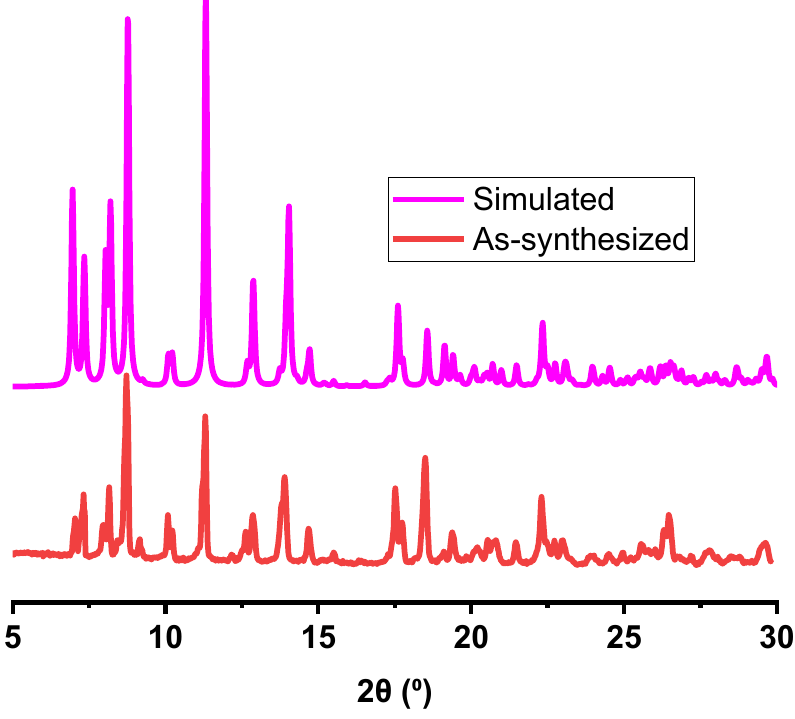
Figure 2. Powder XRD spectra of the as − synthesized and simulated CdMOF. From the literature point of view, four (04) MOF crystal structures are found that have close similarities with the crystal structure of CdMOF. These MOFs’ crystal structures have the same and/or similar fully deprotonated organic linker (H 4 L, amide contain- ing tetracarboxylic ligand) as in CdMOF but have different metal centers. Mn(II)-MOF, [Mn 2 (L)(H 2 O) 3 ] · (H 2 O) 4.8 is a 3D framework having a triclinic crystal system with space − group P 1 and Z = 2 [35], Co(II)-MOF {[Co 2 (L)(H 2 O) 3 ] · S x } n is a 3D framework structure of monoclinic crystal system having P2 1 and Z = 1, [28], and both the Cd(II)-MOF [30] and the Zn(II)-MOF, Cd(L) · (HDMA) 2 (DMF)(H 2 O) 3 and Zn(L) · (HDMA) 2 (DMF)(H 2 O) 6 , respectively, are 3D frameworks with triclinic crystal systems with P -1 space groups and Z = 2 [30]. In all these selected crystal structures, the coordination geometry around metal centers is octahedral and the crystal structure exhibits a 3D framework. However, only in the crystal structure of Mn(II)-MOF, one of the O-atom of amide groups is involved in coordination with the metal center. The intermolecular H-bonding of type O-H · · · O and comparatively weak C-H · · · N and C-H · · · O are responsible for the crystal packing as given in Table S3 and shown in Figure S3. The crystal structure of CdMOF possesses a large channel along a -axis (Figure 5). The pore size calculated by using X-rays diffraction data is 13.2 × 7.16 Å 2 . Inside the channel, there are the coordinated and the guest solvent molecules (DMF and H 2 O) that help in stabilizing the 3D